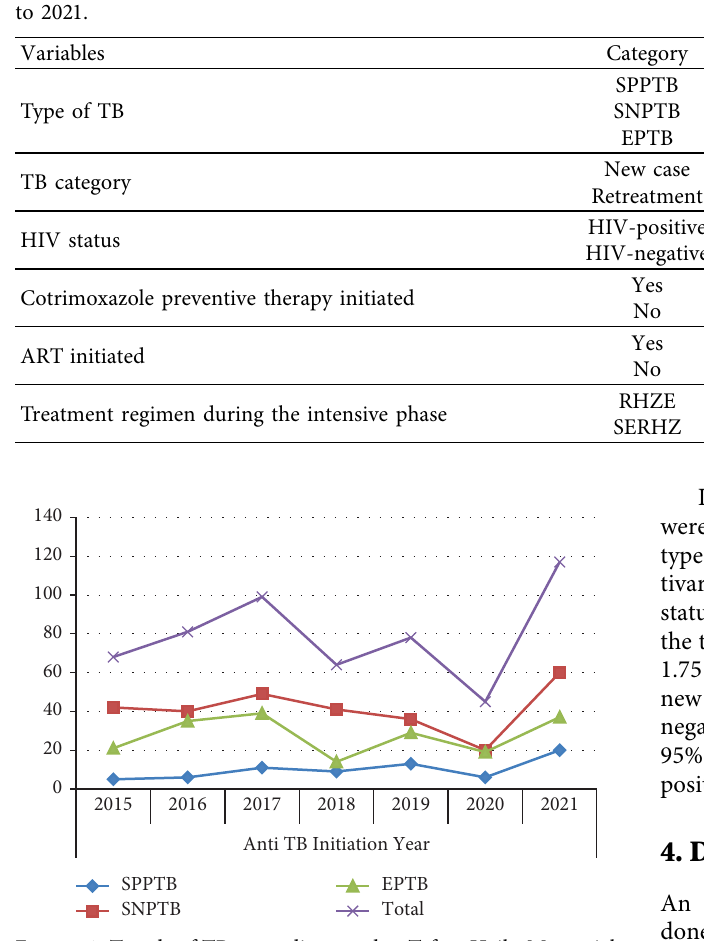
Figure 1: Trends of TB types diagnosed at Tefera Hailu Memorial General Hospital, Sekota town, Northeast Ethiopia from 2015 to